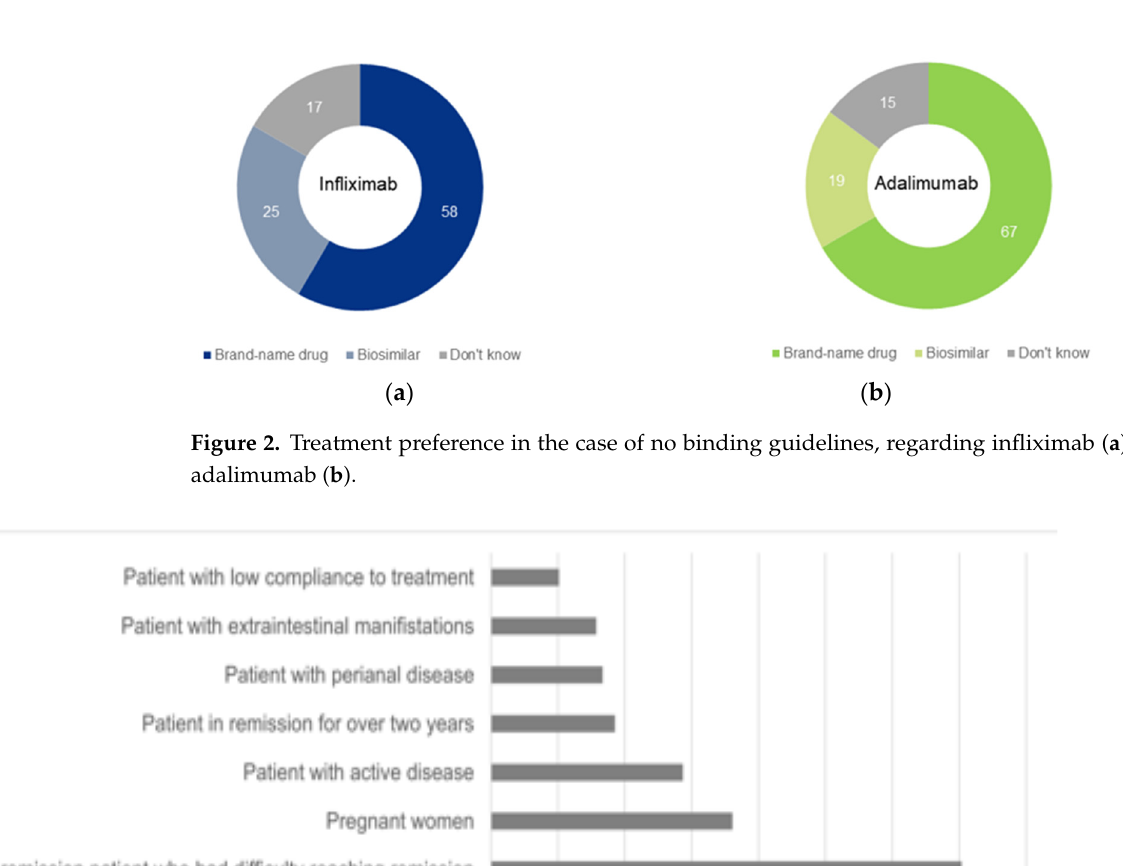
Figure 1. Geographic location of physicians’ workplace.